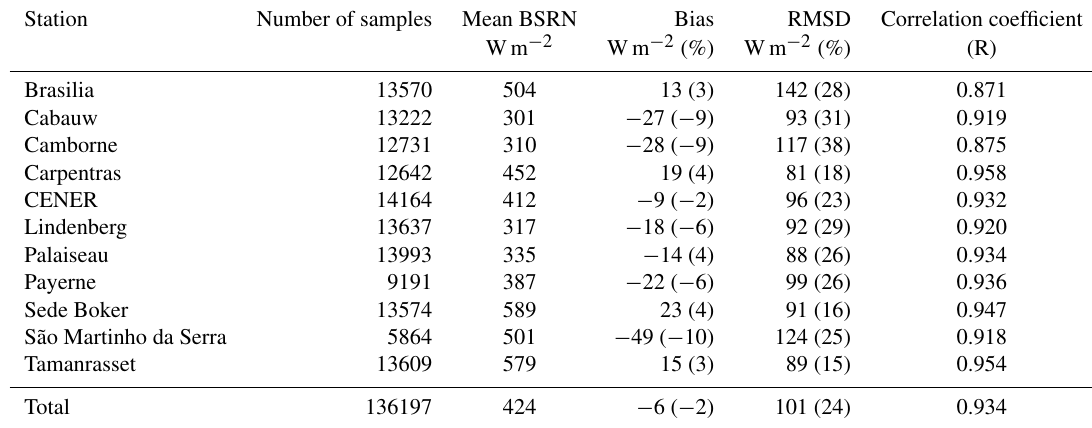
Table B1. Validation results for 15min means of the all-sky DSSI for the year 2011. Results based on the imagery of the Meteosat-9/SEVIRI 0.8µm